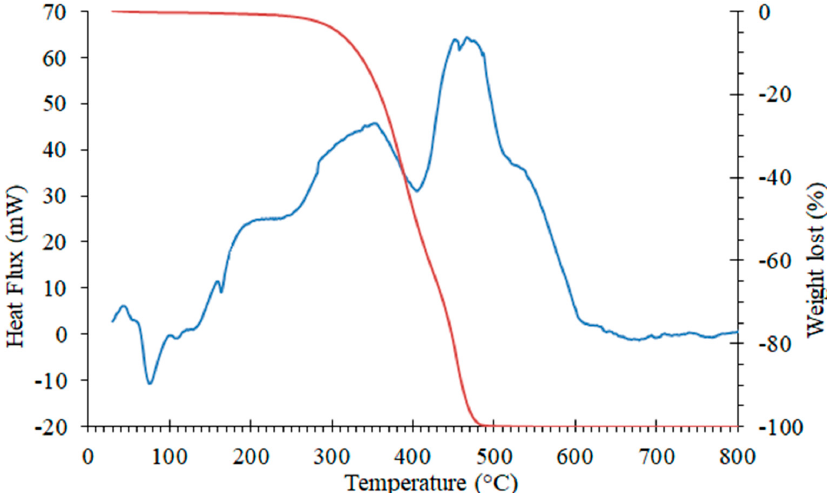
Figure 6. Combination of TGA and DSC results obtained by the application of a heating rate of 10 °C/min in Ar atmosphere for a commercial binder material (M1) (adapted from [16] ), the red curve represents the weight loss and the blue curve represents the heat flux.